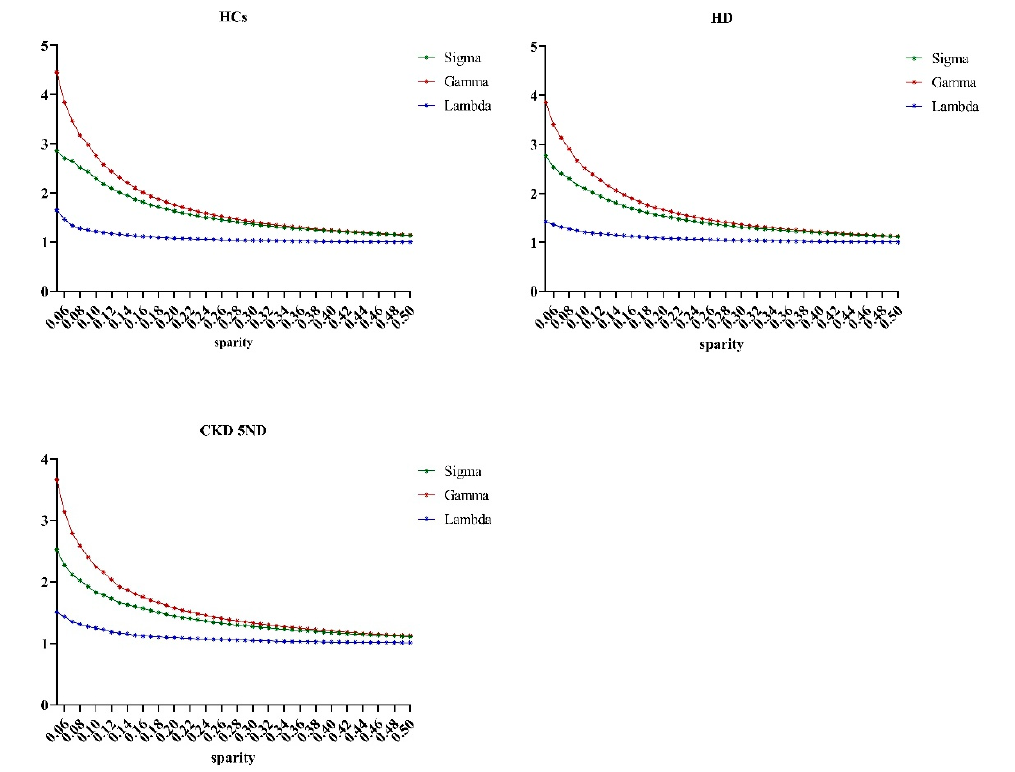
Figure 2. Within all defined sparsity thresholds (0.05–0.5), subjects in all three groups exhibited the small-world attributes, with the Gamma and Sigma values in all three groups greater than 1, and the Lambda value was approximately equal to 1, HCs, healthy controls; CKD5 ND, nondialysis patients with stage 5 chronic kidney disease; HD, hemodialysis patients. Sigma, small-worldness; Gamma, normalized clustering coefficient; Lambda, normalized clustering coefficient.